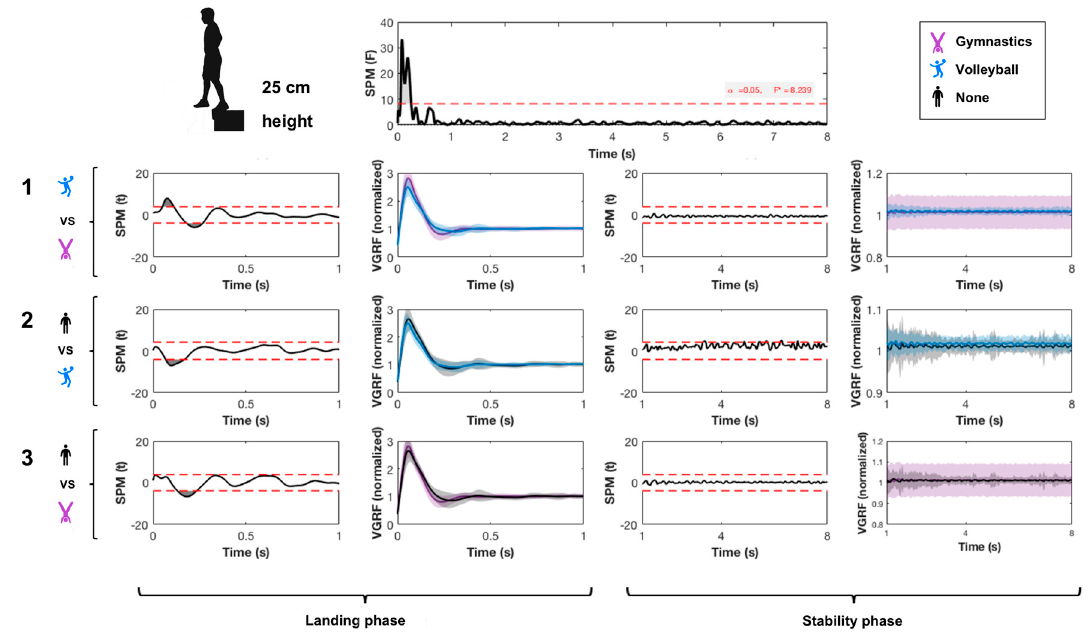
Figure 2. Effect of sports practice on vertical ground reaction force (GRF). SPM refers to statistical parametric mapping. Data acquired during landing and stability phases of single-leg landing from 25 cm height for 8 s are shown and compared. 1 refers to the pairwise comparison between gymnastics and volleyball groups; 2 refers to the pairwise comparison between volleyball and control groups; 3 refers to the pairwise comparison between gymnastics and control groups.